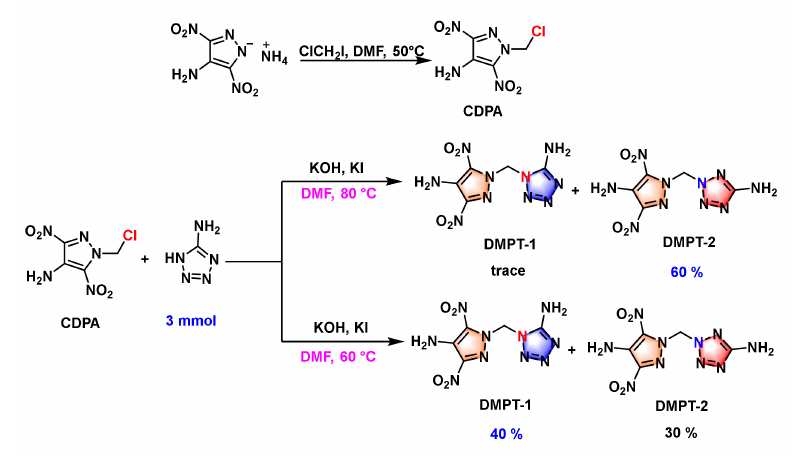
Figure 1. Single-crystal X-ray structures of compounds ( a ) DMPT-1 , ( d ) DMPT-2 ; packing diagrams of ( b ) DMPT-1 , ( c ) DMPT-1 , ( e ) DMPT-2 , ( f ) DMPT-2 .